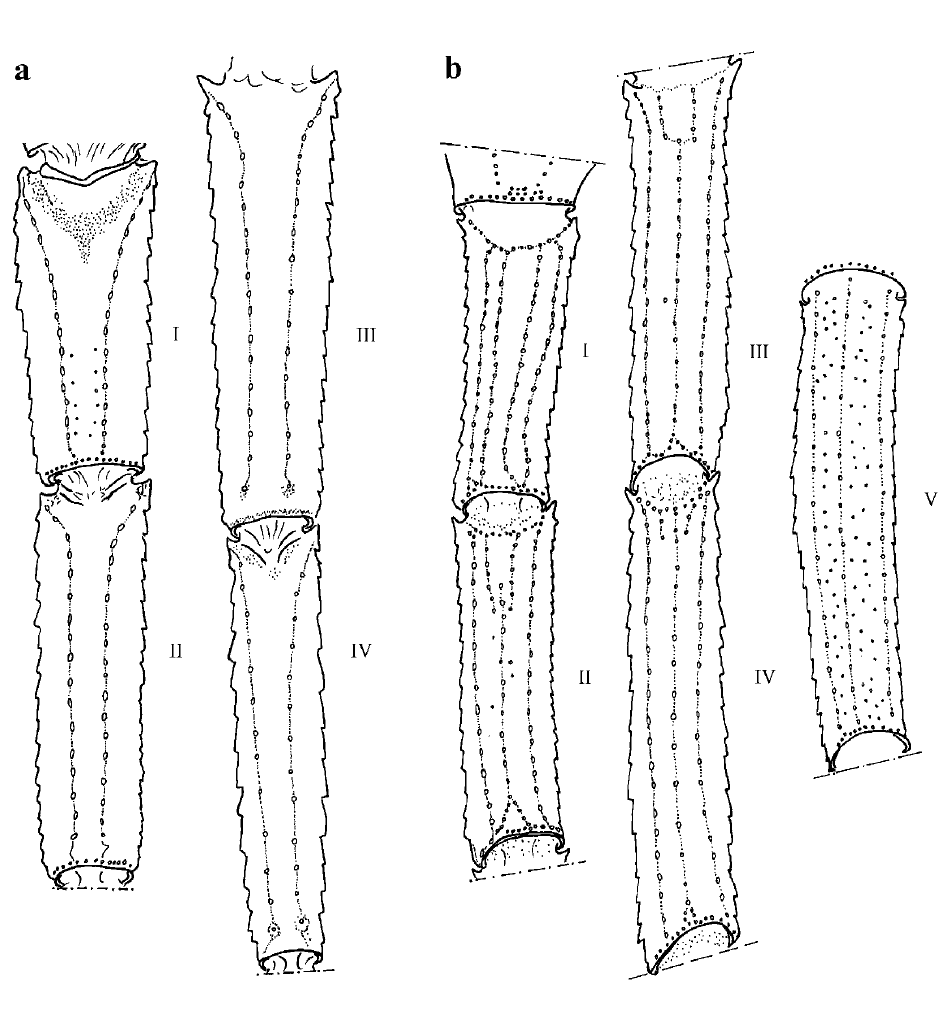
Figure 4 . Tityus gonzalespongai n. sp . Male. a. Caudal segments I-IV. Dorsal view. b. Caudal segments I-V. Ventral